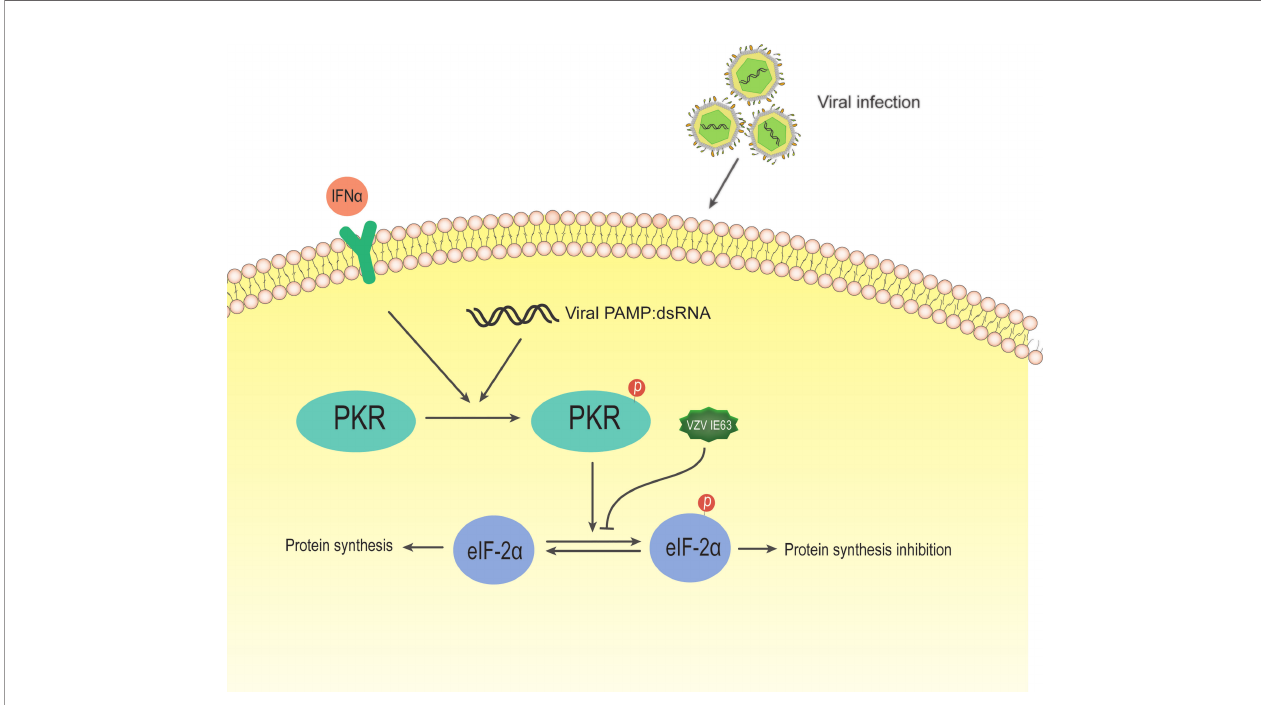
FIGURE 8 | Schematic diagram of VZV IE63 regulating protein synthesis in infected cells. During most viral infections, double-stranded RNA is synthesized or a double-stranded RNA structure is formed. After IFN-induced PKR kinase is activated by double-stranded RNA (dsRNA), activated PKR phosphorylates eIF-2 a , and its phosphorylation causes translational inhibition, thereby inhibiting virus replication. The phosphorylation level of eIF-2 a increases in cells infected with the IE63 mutant. The eIF-2 a phosphorylation level of cells transiently expressing IE63 decreases, indicating that IE63 can promote the expression of VZV virus by inhibiting eIF-2 a